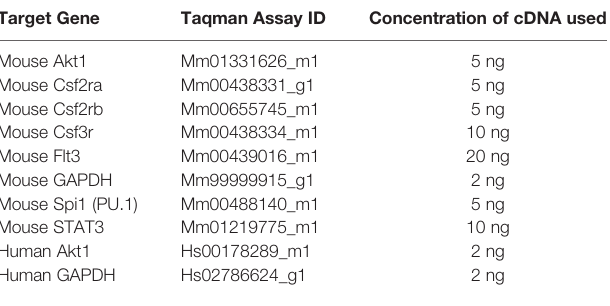
TABLE 2 | Primers used for qRT-PCR. Target